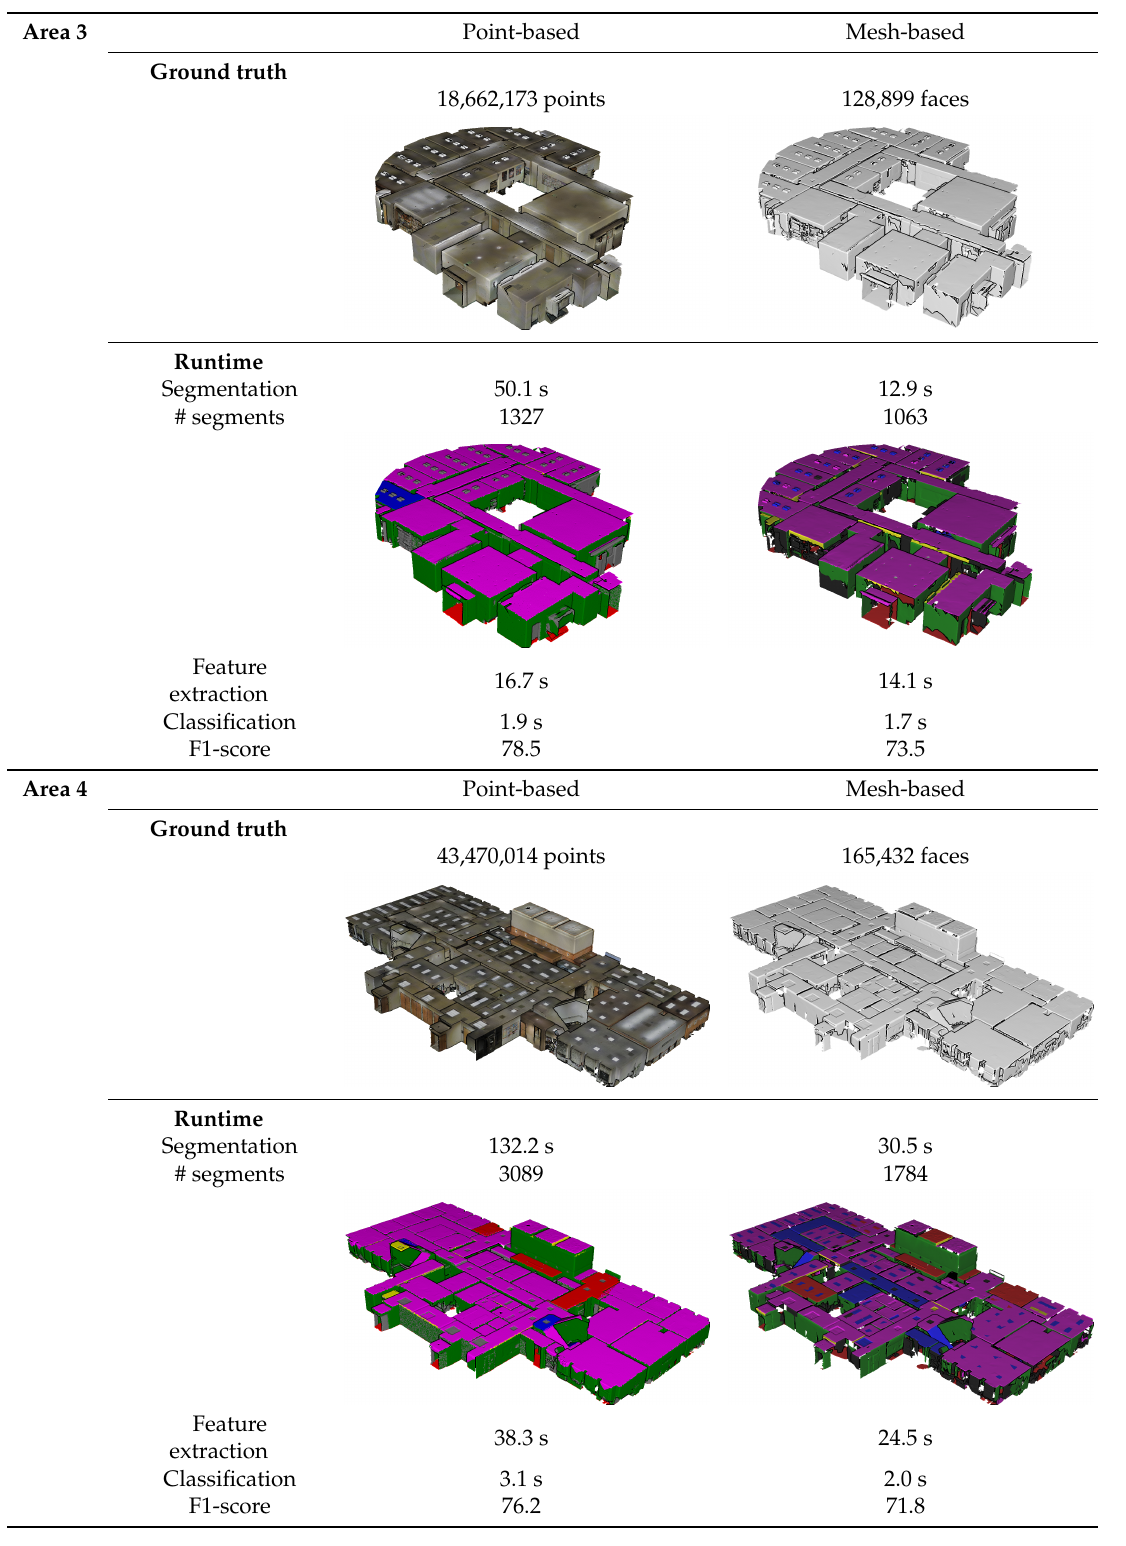
Figure 5. Process information of the point-based and mesh-based